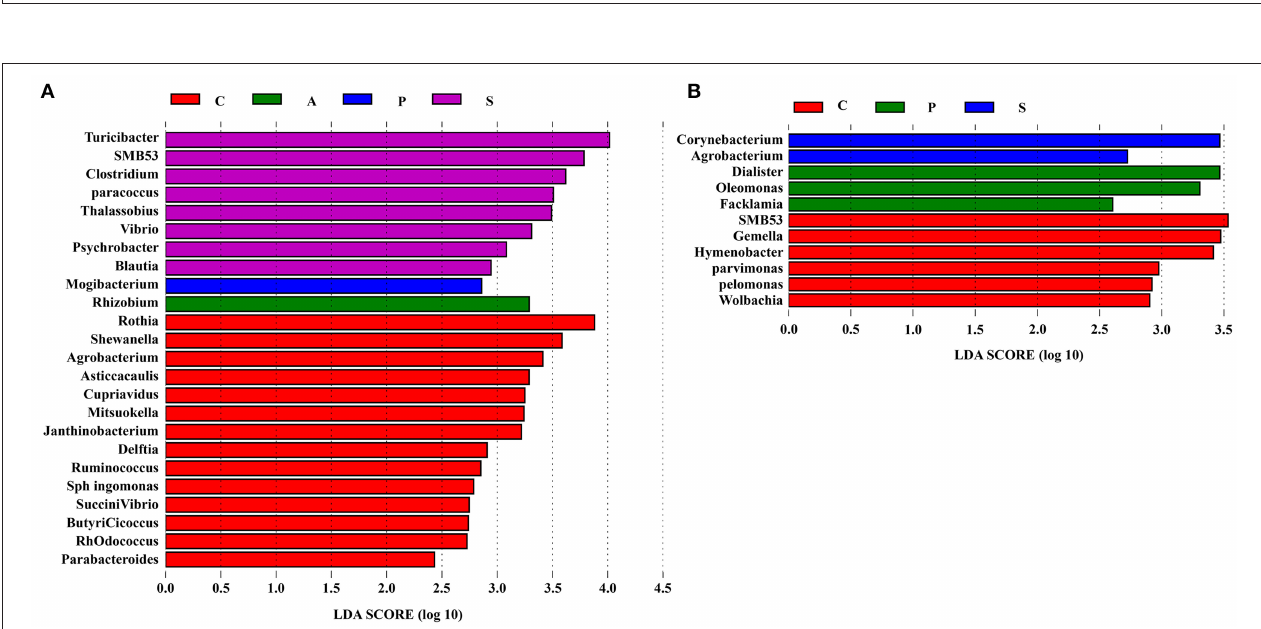
FIGURE 8 | The differentially abundant taxa among the four groups by LEfSe (LDA Effect Size) analysis. Histograms of a linear discriminant analysis (LDA) score (threshold: ≥ 2) in (A) jejunum and (B) ileum. n = 8 per group. C, control group; A, antibiotic group; P, probiotic group; and S, synbiotic group.